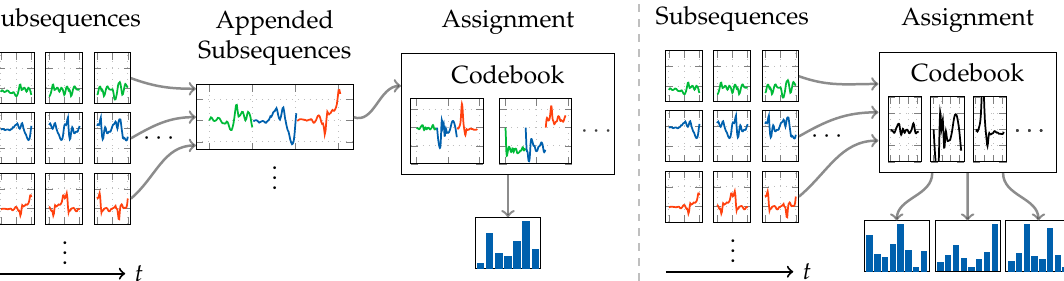
Figure 7. Diagrams visualizing the strategies for using a single codebook with multiple sensor channels as used by [19] ( left ) and us ( right ). With the left variant, subsequences from all channels are appended to a vector that is then used for codebook assignment, producing only one histogram feature vector per time-window and sensor. The variant on the right treats subsequences of all sensor channels equally, and assigns them using the same codebook, resulting in 3 independent histogram feature